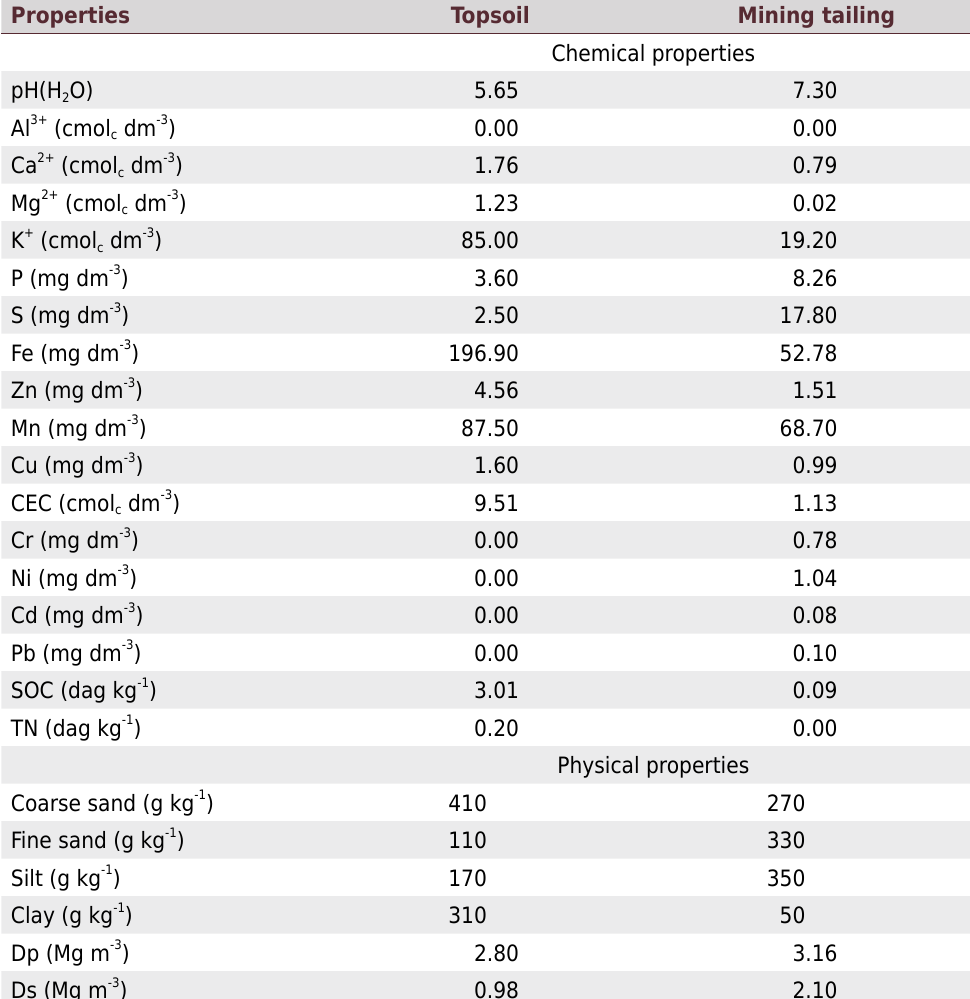
Table 1. Chemical and physical properties of topsoil and mining